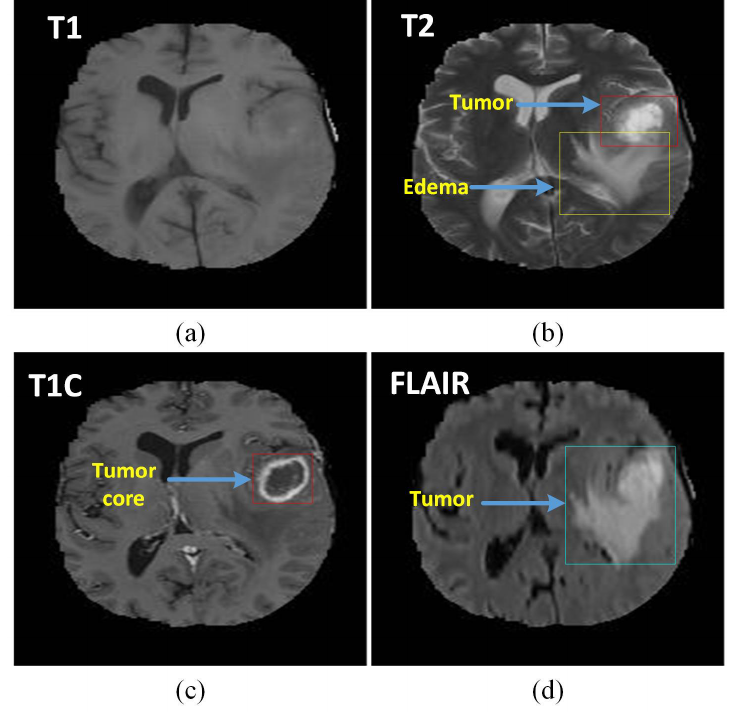
Figure 2. The different tumor types with different shapes in four magnetic resonance images (MRI) sequences: ( a ) T1 MRI sequence, ( b ) T2 MRI sequence with tumor type edema, ( c ) T1C MRI sequence with core tumor, and ( d ) Search Results Web results Fluid attenuation inversion recovery (FLAIR) sequence showing the ground truth of a